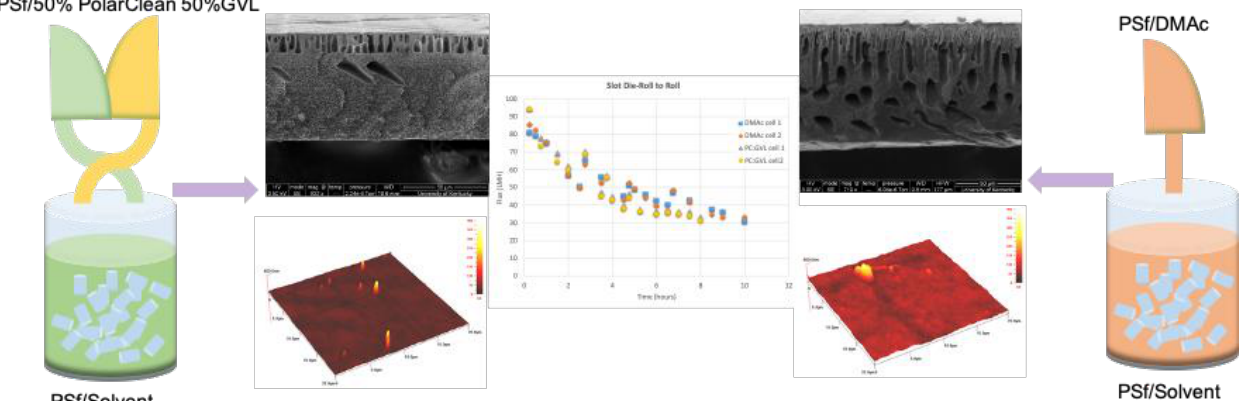
Figure 8. Cross-sectional morphologies, atomic force microscopy imaging to show roughness, and comparison of flux decline for membranes made from dopes that used the PolarClean and GVL as co-solvents to those made using the petroleum-derived solvent.